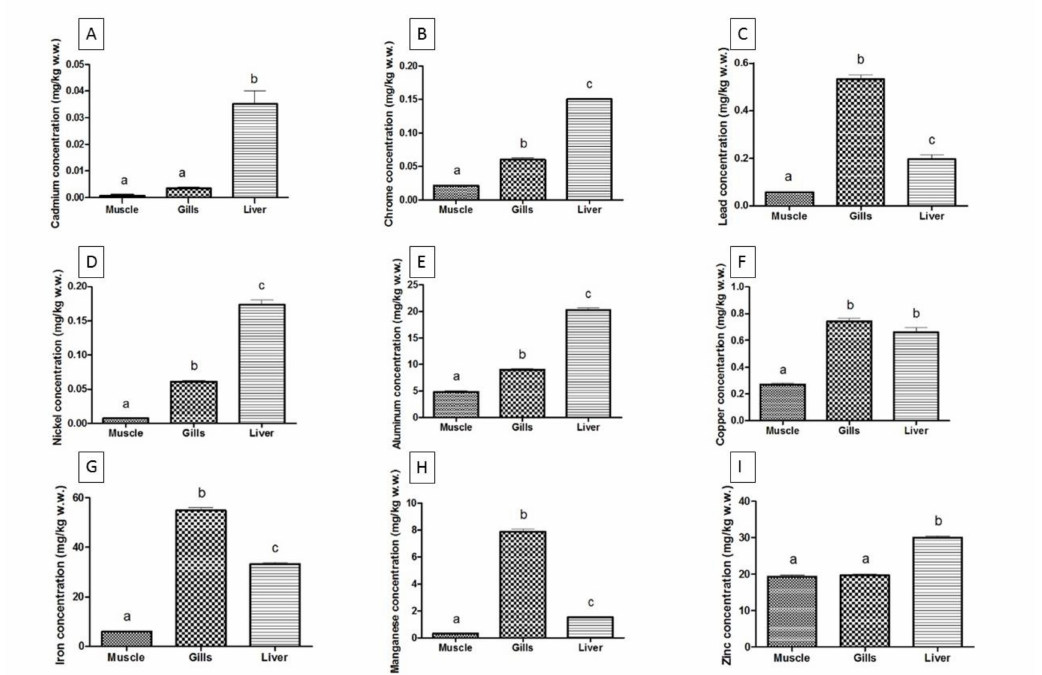
Figure 2. Metal concentration in di ff erent tissues of Mugil cephalus (Linnaeus, 1758) from the Ionian Sea, Italy. Di ff erent alphabetical characters represent statistical di ff erences ( p < 0.05). From ( A – I ) are plotted metal concentrations in the following order: Cd, Cr, Pb, Ni, Al, Cu, Fe, Mn, and